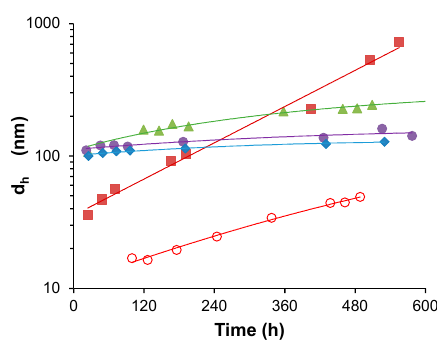
Figure 5. Colloidal dispersions of (1:1) S-PMOTAI particles prepared at pH 6.0 (red circles ο ), pH 6.7 (dark red squares ■ ), pH 7.8 (green triangles ▲ ), pH 7.9 (purple circles ● ) and pH 8.6 (blue diamonds ♦ ). A constant 10 mM concentration of MOTAI repeating units is used (2.99 g/L). The mean hydrodynamic diameter ( d h , nm) is shown as a function of time (h). Lines are drawn only as a guide for the eye.